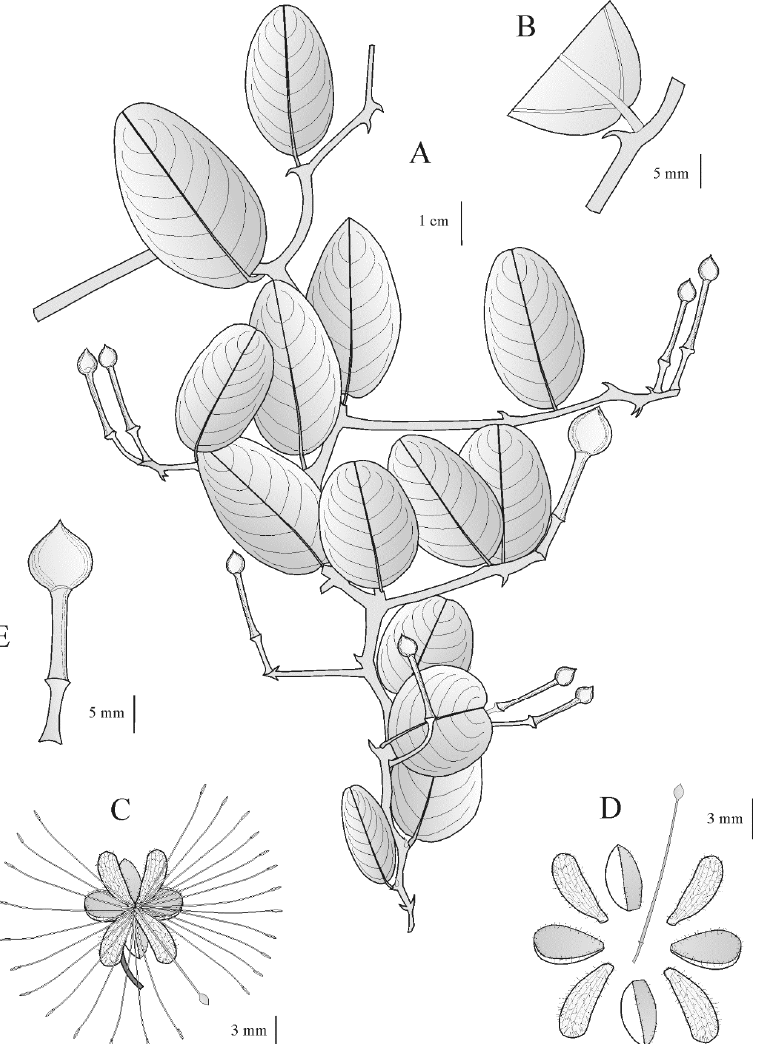
Figure 1. Capparis oxycarpa : ( A ) fruiting branch; ( B ) stipular thorn and base of leaf blade; ( C ) flower; ( D ) dissected flower showing sepals, petals, gynophore and ovary; ( E ) fruit and stipe; ( A , B , E ) from holotype ( Averyanov & Kudryavtzeva 83); ( C , D ) from Kudryavtzeva & Ogureeva 134. Drawn by S. Fici.